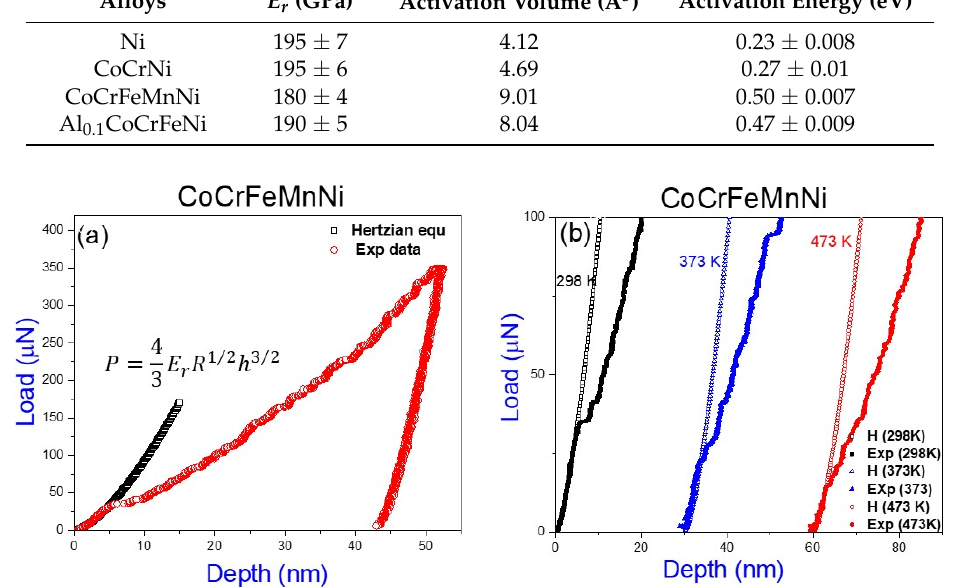
Figure 3. ( a ) Representative load-displacement curve of CoCrFeMnNi alloy at room temperature along with the Hertzian; ( b ) load-displacement curve of CoCrFeMnNi alloy at different temperatures along with the Hertzian fitting for the elastic section.